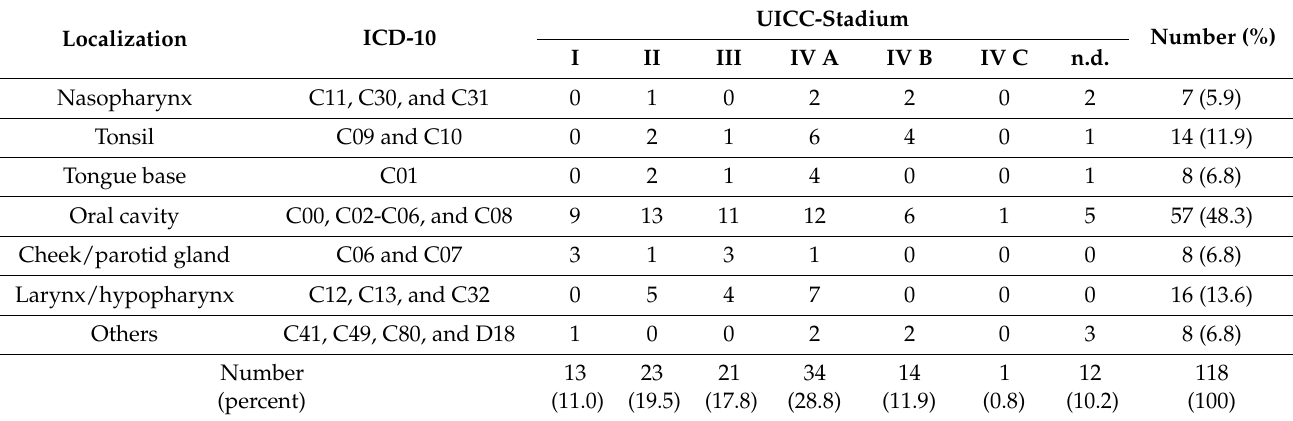
Table 1. Tumor localization and tumor stage according to ICD-10 and UICC.